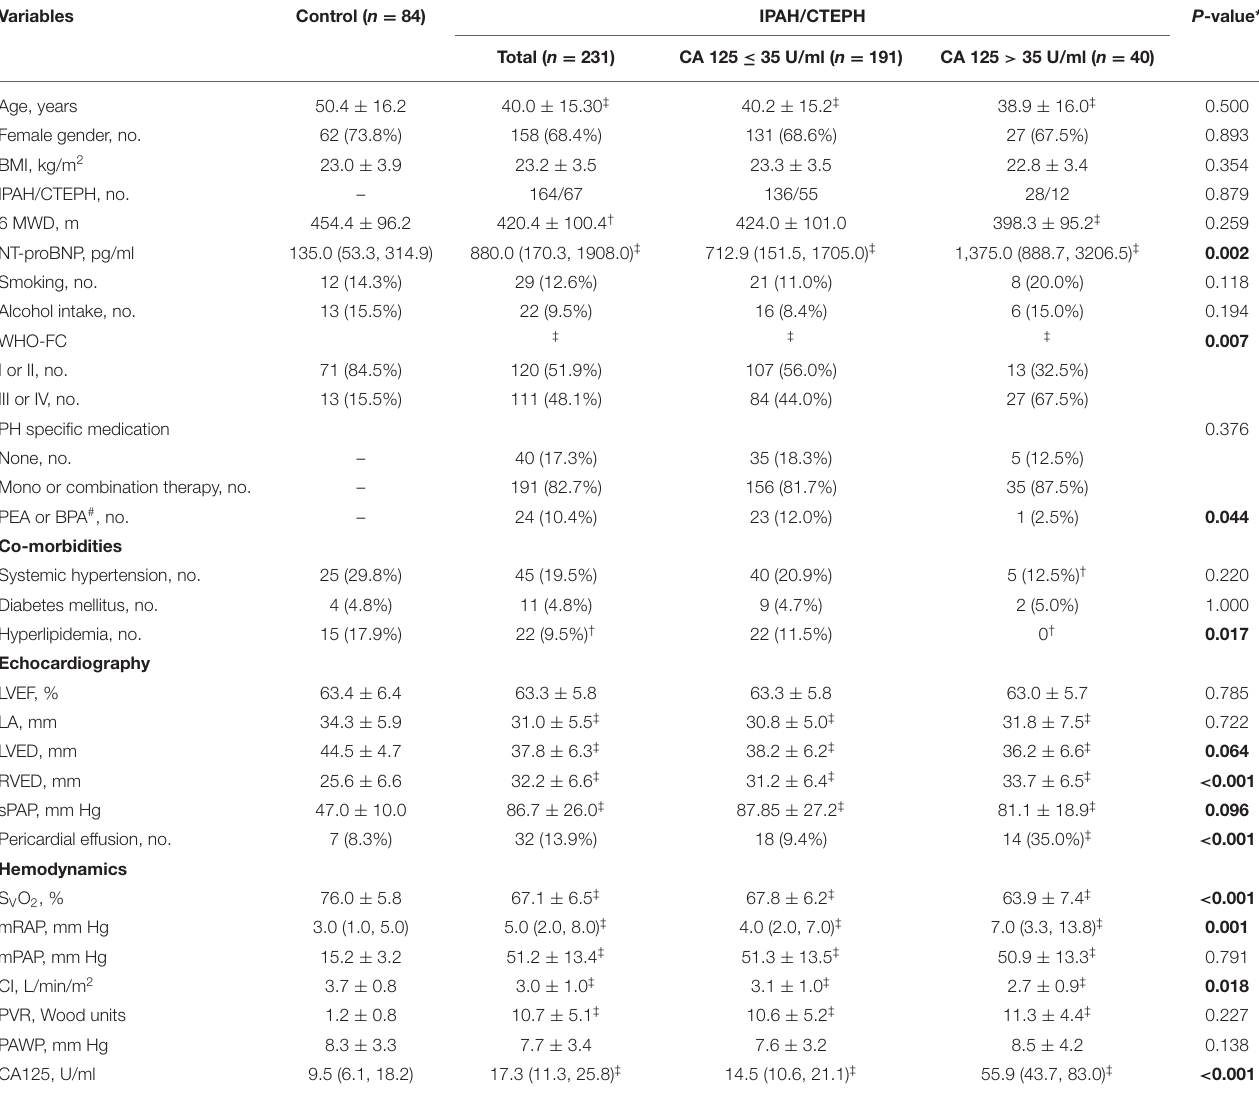
TABLE 1 | Basic characteristics of control group and patients with PH. Variables